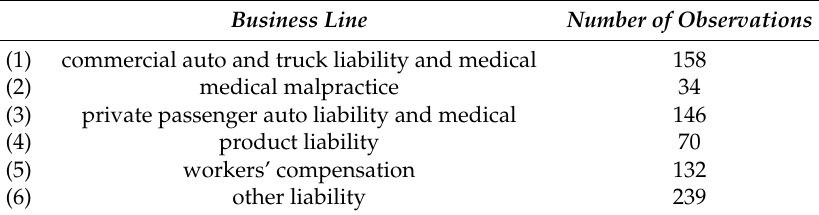
Table 1. Number of observations (insurance institutions) in the data